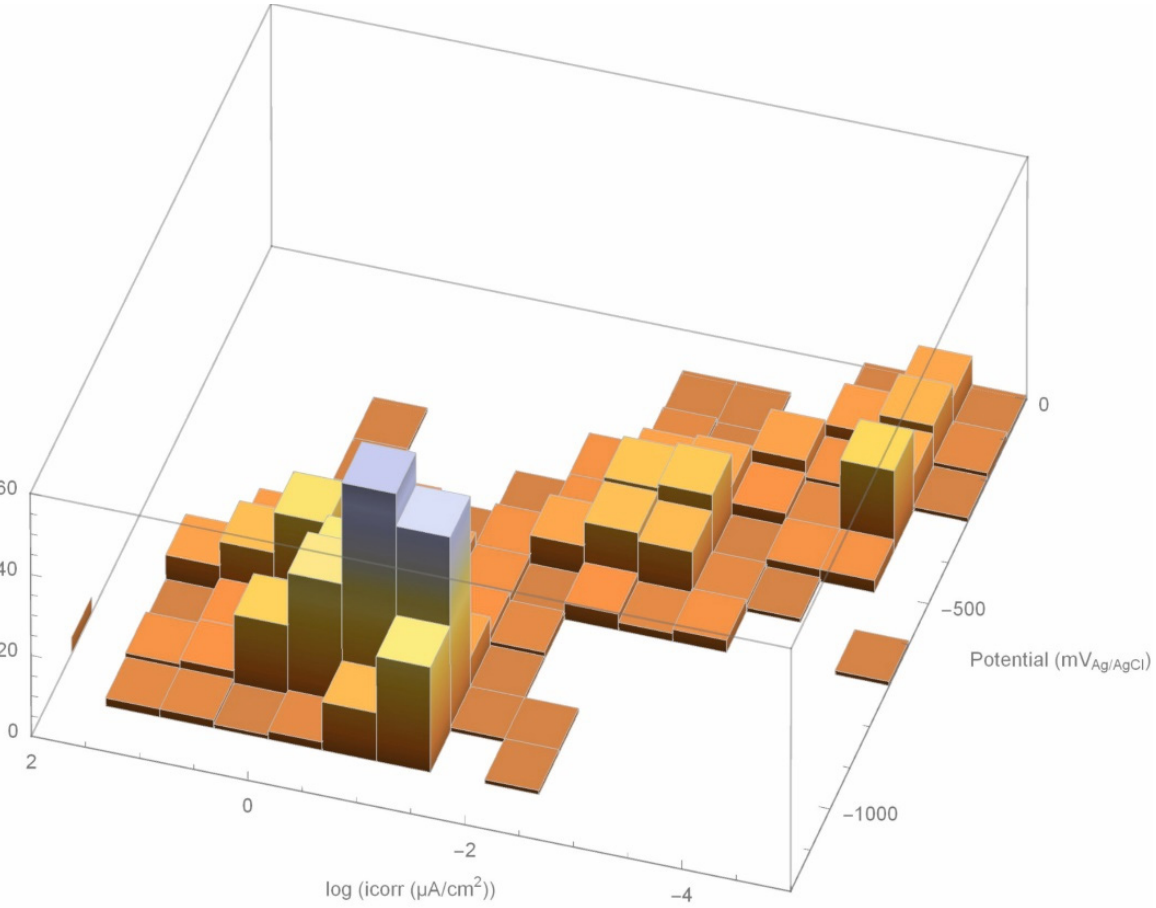
Figure 14. Population diagram based on the Evans diagram.